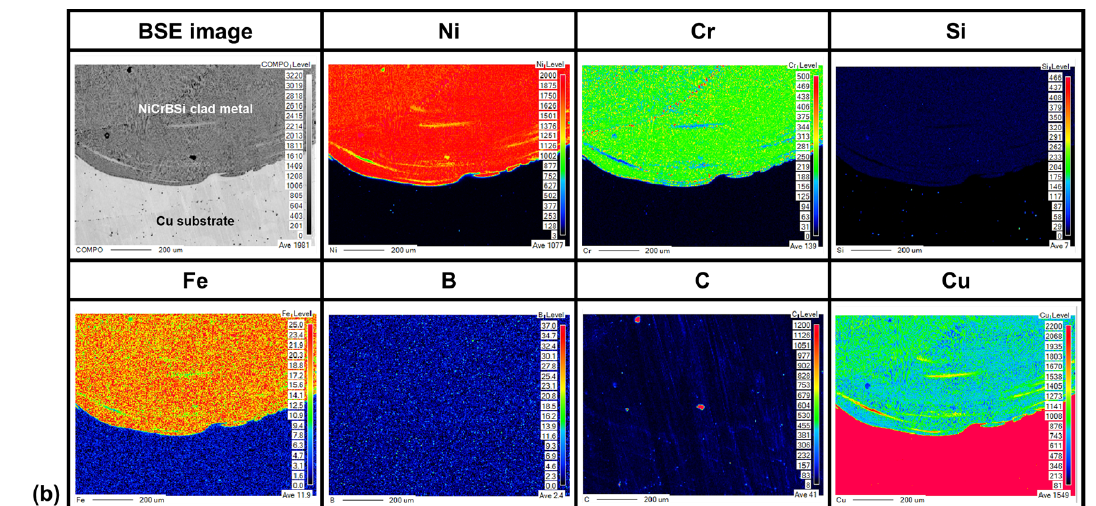
Figure 4. Backscattered electron (BSE) image and elemental distribution maps analyzed by EPMA for the as-clad specimen: ( a ) near the surface, and ( b ) near the faying surface.